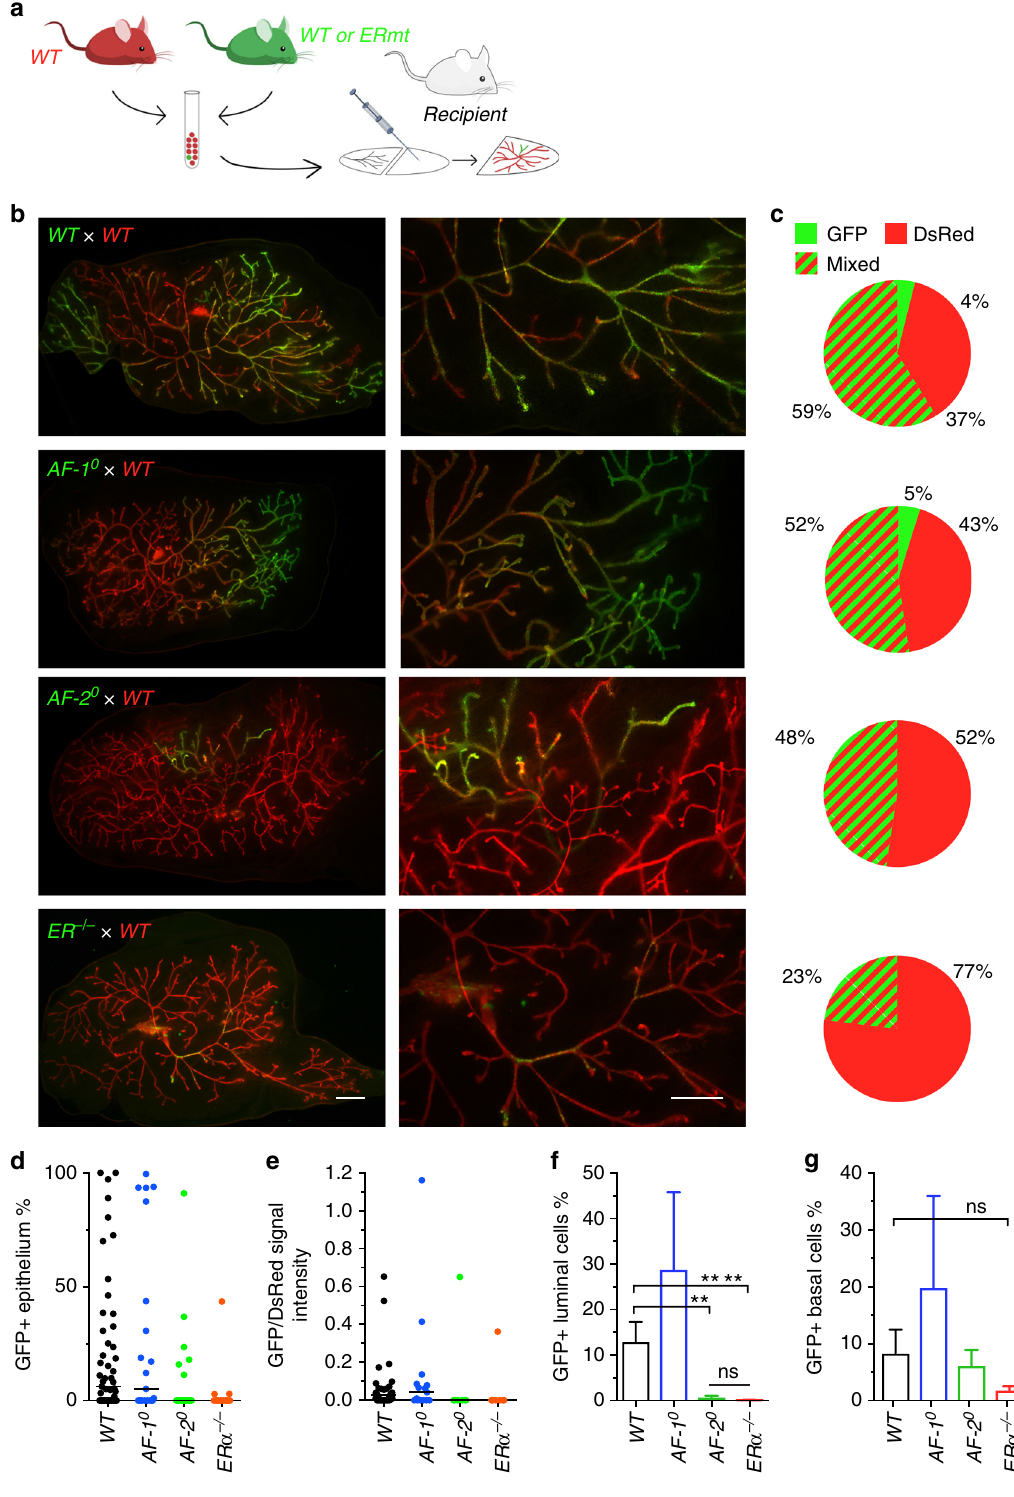
chimeras (Fig. 4b, c). AF-2 0 .GFP + :WT.DsRed + chimeras were more similar to ER α − / − .GFP + : WT.DsRed + chimeras with